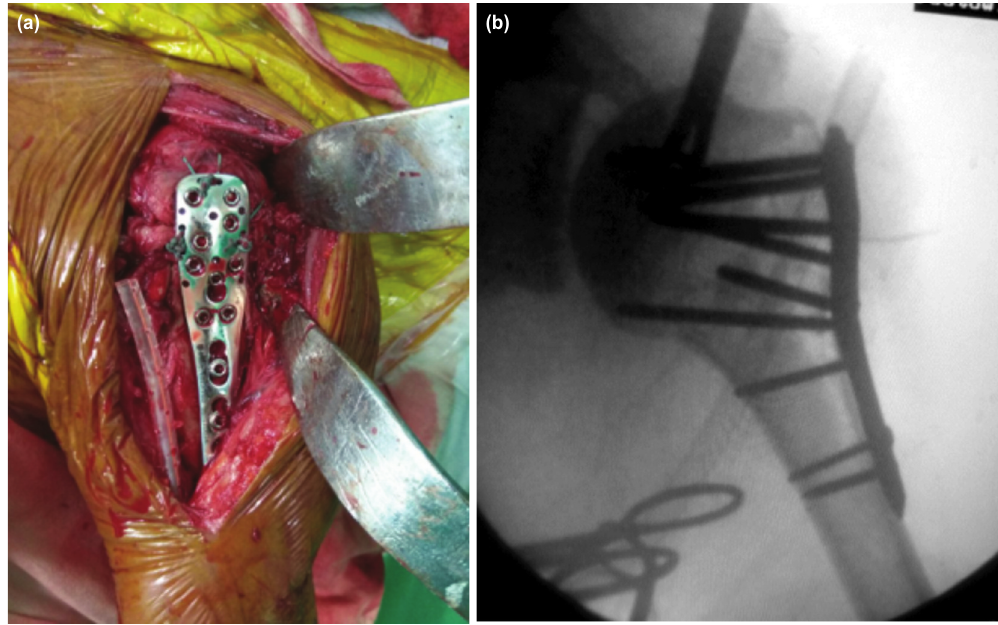
(a, b) Plate position and intra-operative Fig. 2: